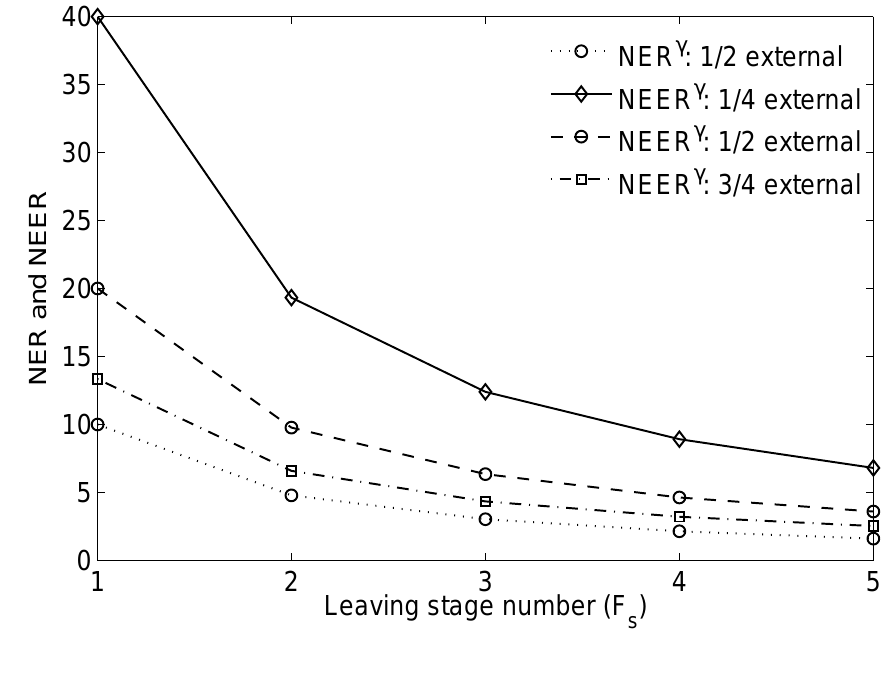
Figure 7. Comparison between EER γ and NER γ with changes in the makeup of consumption between internal ( X ) and external ( E ) consumption. In all cases indirect consumption is equal to